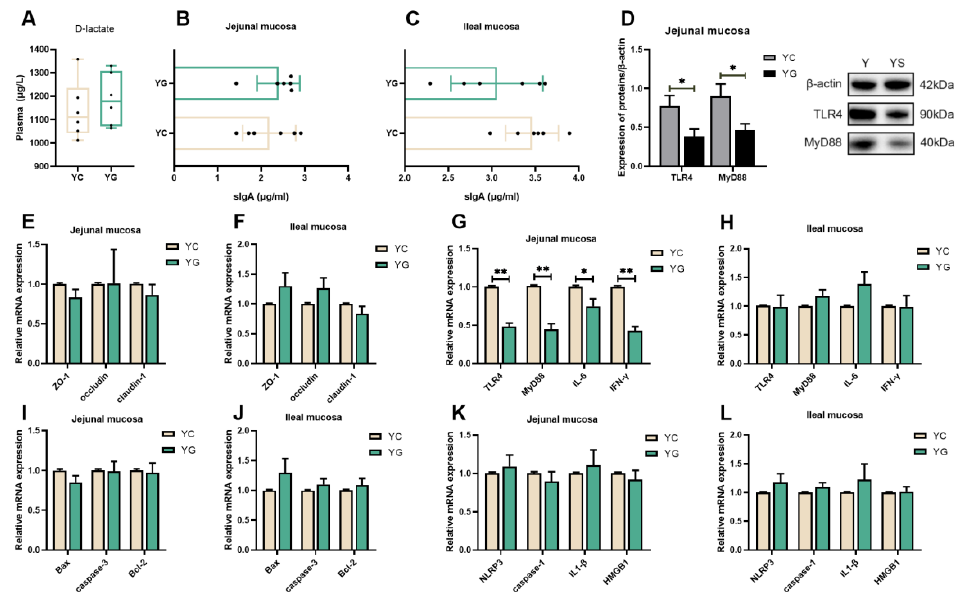
Figure 7. Effects of a glucose-supplemented diet on intestinal damage induced by chronic cold stress. ( A ) The level of D-lactate in the plasma of Yorkshire pigs (n = 6). ( B , C ) The content of sIgA in the intestinal mucosa of Yorkshire pigs (n = 6). ( D ) The proteins expression levels of TLR4 and MyD88 in the jejunal mucosa of Yorkshire pigs (n = 6). ( E , F ) The mRNA expression levels of tight-junction proteins in the intestinal mucosa of Yorkshire pigs (n = 6). ( G , H ) The mRNA expression of TLR4, MyD88, and inflammatory factor in the intestinal mucosa of Yorkshire pigs (n = 6). ( I , J ) The mRNA expression of key genes of apoptosis in the intestinal mucosa of Yorkshire pigs (n = 6). ( K , L ) The mRNA expression of key genes of pyroptosis in the intestinal mucosa of Yorkshire pigs (n = 6). Data are presented as the means ± SEM. * p < 0.05, ** p < 0.01.